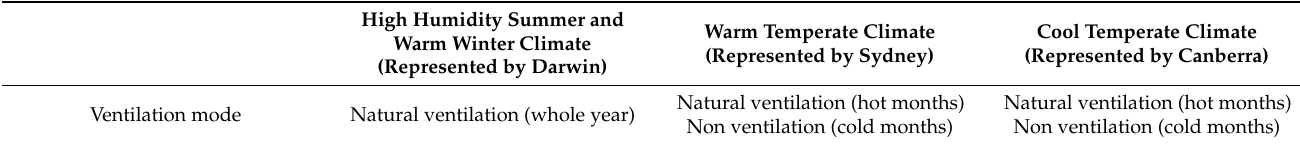
Table 2. Ventilation modes used for different climate conditions [28,29].